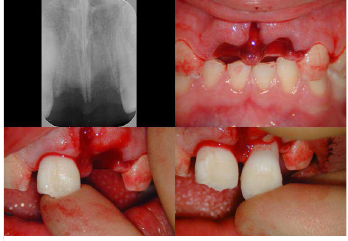
Figure 2. Replantation of the